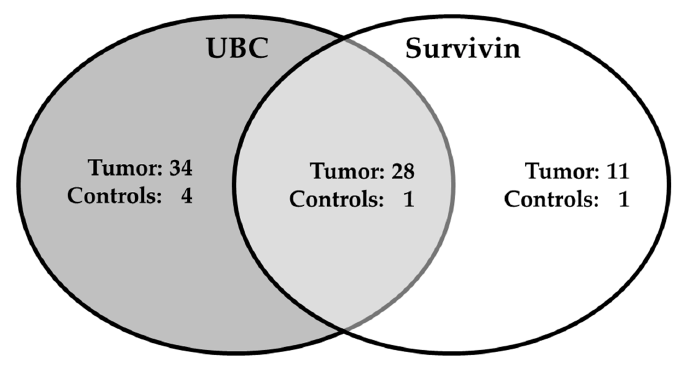
Figure 4. Venn diagrams of all positive test results. The cut-off for UBC ® Rapid was >10 mg/L ( left ) and for survivin >0.033 ng/mL ( right